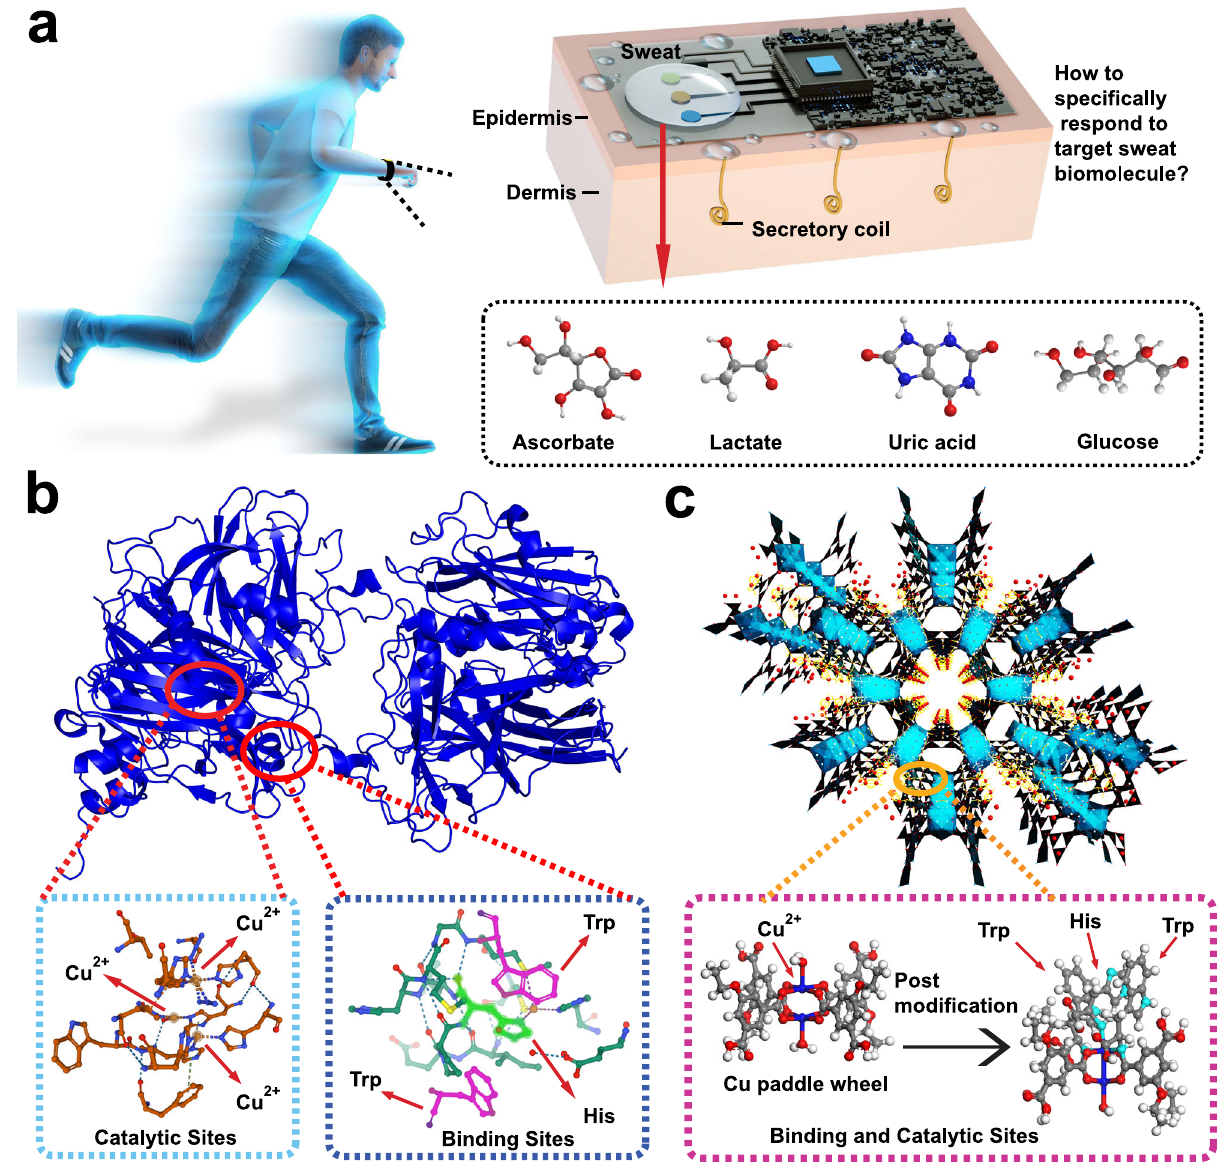
Fig. 1 | Customizing nanoenzymes inspired by natural ascorbate oxidase for sweat ascorbate sensing. a Sweat sensors for noninvasive health monitoring, b natural ascorbate oxidase with Cu catalytic and speci fi c binding sites formed by